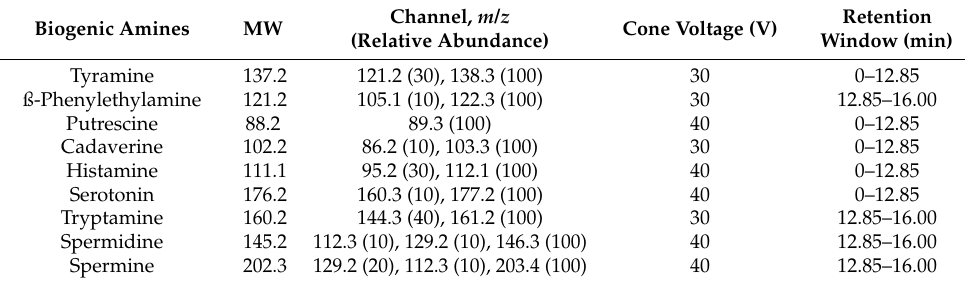
Table 3. Data acquisition parameters used in LC-ESI-MS for BA